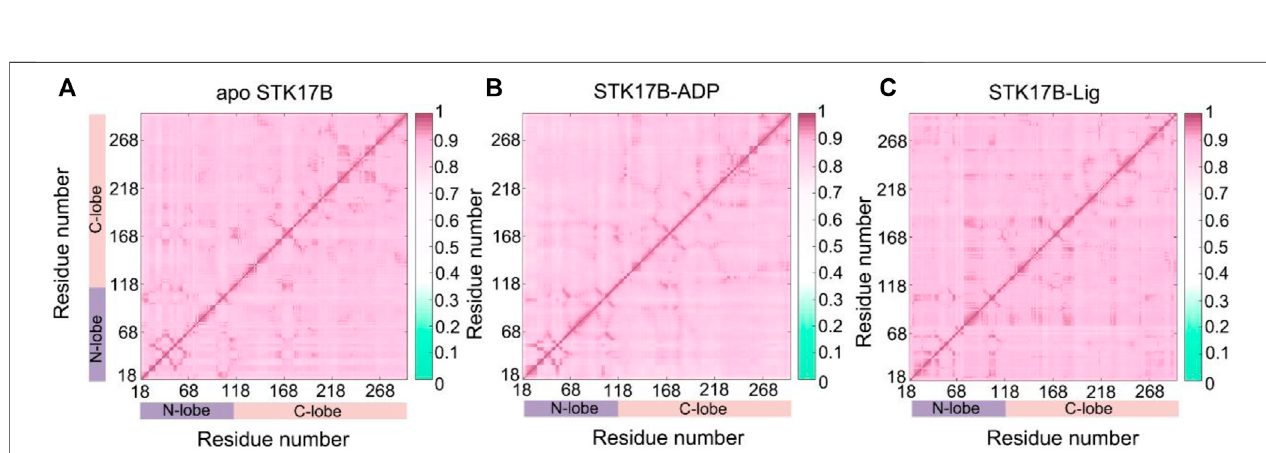
FIGURE 2 | The cross-correlation (CC ij ) matrix of STK17B for the apo (A) , ADP-bound (B) , and ligand-bound (C) systems. The correlated motions are colored by violent (CC ij > 0), while the anti-correlated motions are colored by cyan (CC ij < 0). Color scales are shown at the right. The CC ij values with an absolute correlation coef fi cient of < 0.4 are colored by white for clarity.